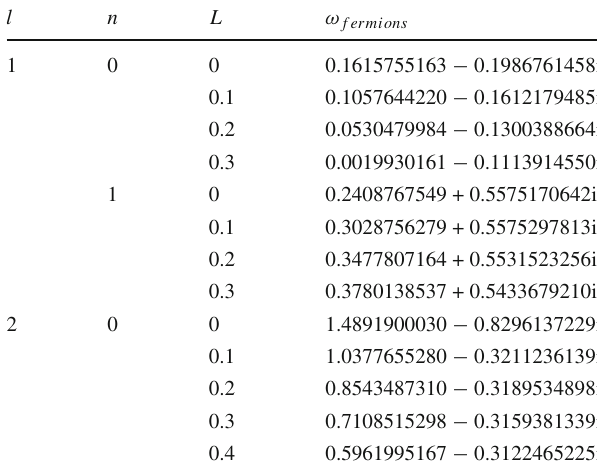
Table 2 QNMs of Dirac waves in the slowly rotating Kerr-like black hole